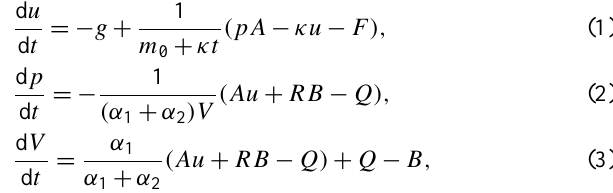
Figure 2. (a) projection of the phase portrait of the determinis- Figure 2. (a) Projection of the phase portrait of the deterministic system, p (Pa) vs. u ( m s − 1 ). (b) illustrates an tic system, p (Pa) vs. u (ms − 1 ). (b) illustrates an enlargement near unstable equilibrium (open circle). The dashed red line is enlargement near unstable equilibrium (open circle). The dashed red line is a pseudo-separatrix. Physical pa- a pseudo-separatrix. Physical parameters of the system under con- rameters of the system under consideration are (Iverson et al., 2006): B = Q = 2 m 3 s − 1 , m 3.6 10 10 kg, sideration are (Iverson et al., 2006) B = Q = 2 m 3 s − 1 , m 0 = 3.6 × 0 = × 10 10 kg, A = 30000m 2 , p 0 = 12936 × 10 3 Pa, α 1 = 10 − 7 Pa − 1 , 7 Pa 1 , α 9 Pa 1 , F 10 3 Pa , α 3528 10 7 kg m s − 2 , u A = 30 000 m 2 , p 0 = 12 936 − − ref = 1 = 10 − 2 = 10 − 0 = α 2 = 10 − 9 Pa − 1 , F 0 = 3528 × 10 7 kgms − 2 , u ref = 0 . 1 Q/A = × × 6.67 × 10 − 6 ms − 1 , V 0 = 6.32 × 10 5 m 3 , c = 1.7 × 10 − 4 , g = 9 . 8 3 , 10 2 m s − 1 , V 6.32 10 5 m 3 , c = 1.7 10 − 4 , g = 9 . 8 m s − 2 , ρ 0 . 1 Q/A = 66 667 0 = 0 = ρ r = 2000 kg m − × × × ms − 2 , ρ 0 = ρ r = 2000 kgm − 3 , and κ = κ = 0 .